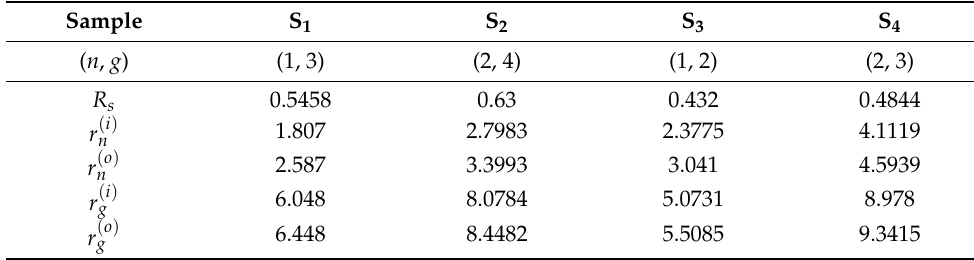
Table 1. Parameters of designed four samples (the two VBs of orders n and g to be superimposed have the equal doughnut radius R s